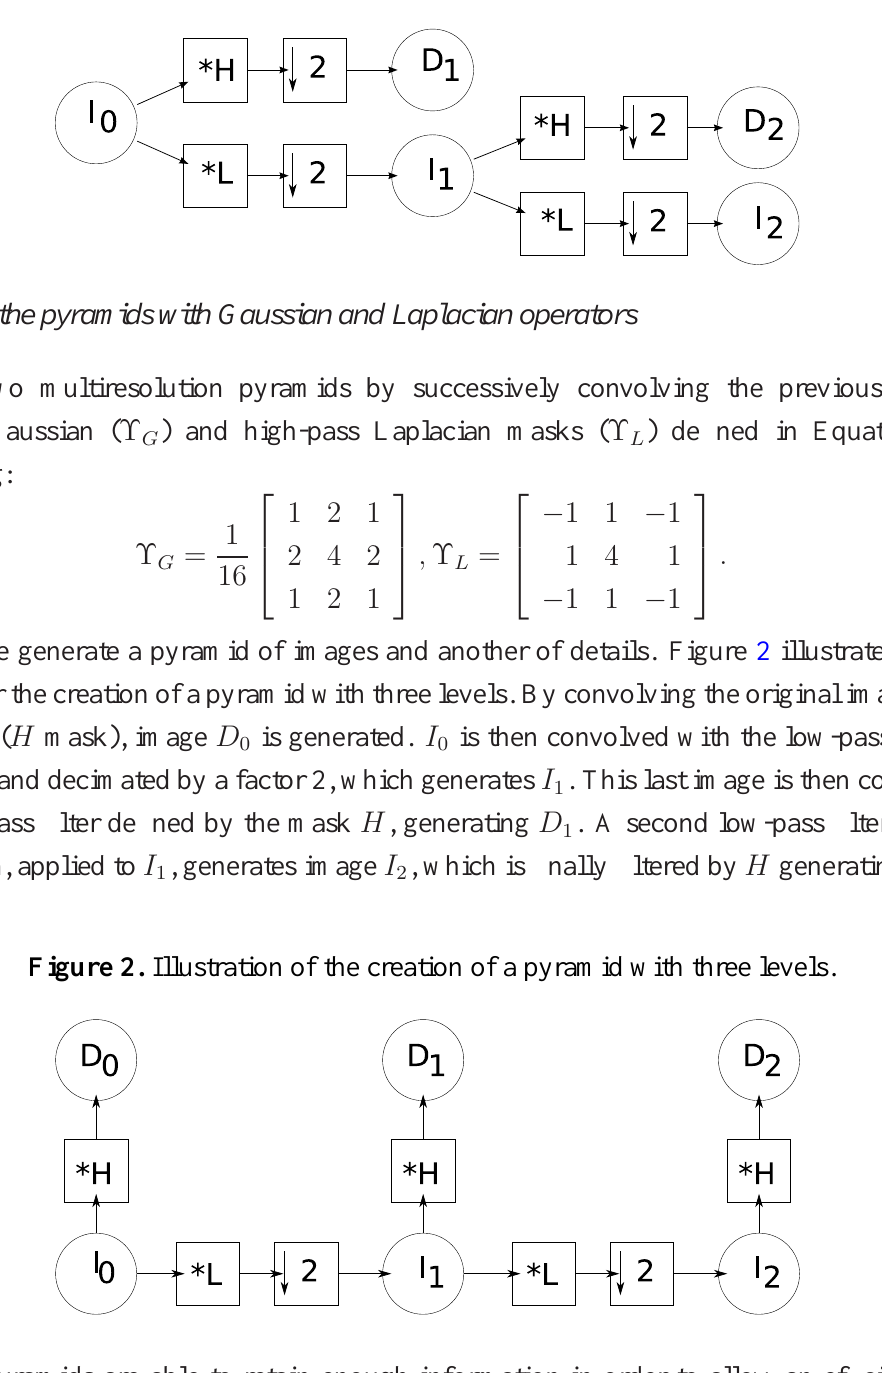
Figure 1. Creation of a pyramid with wavelet transform.